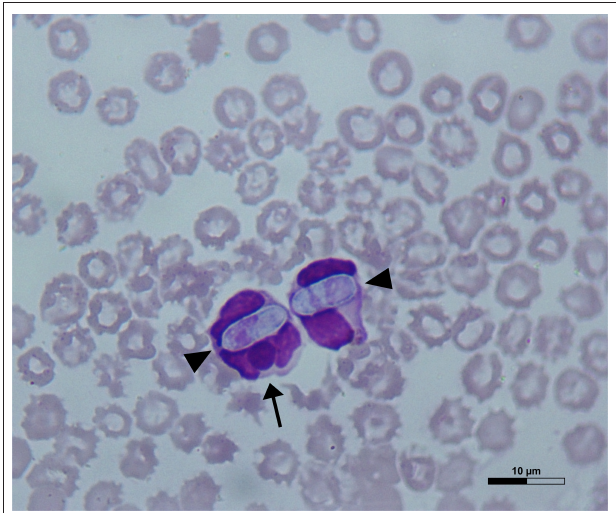
FIGURE 1 | A May-Grünwald Giemsa-stained blood smear from Dog 1 showing Hepatozoon canis gamonts (arrowheads) and Ehrlichia canis morula (arrow) within a monocyte on the left and a granulocyte on the